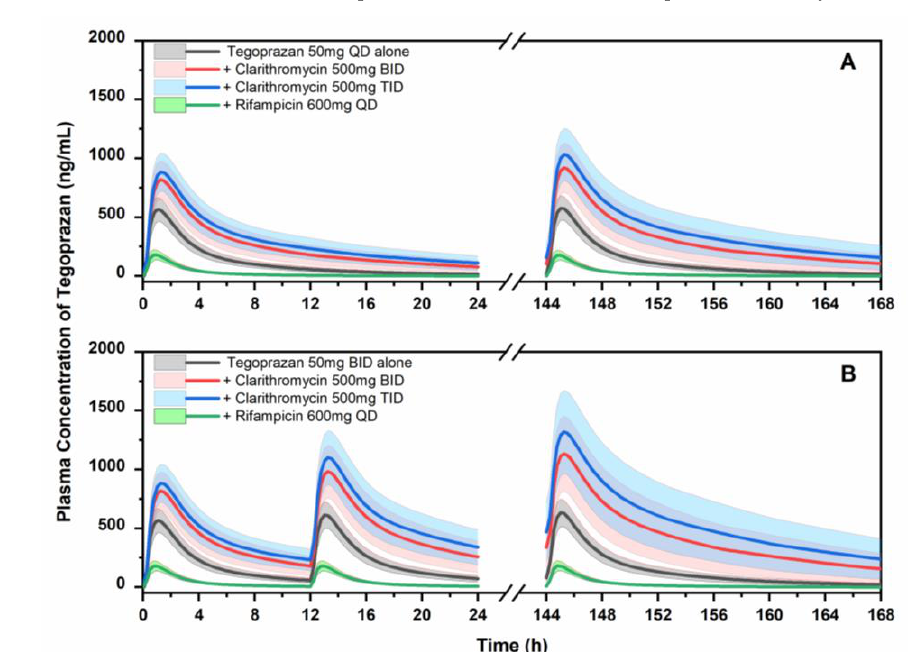
Figure 5. The PK profiles of tegoprazan following the administration of tegoprazan alone or with CYP3A4 perpetrators in a variety of scenarios. ( A ) Tegoprazan, 50 mg, once daily; ( B ) Tegoprazan, 50 mg, twice daily. Dose of clarithromycin: 500 mg, twice or three times daily. Dose of rifampicin: 600 mg, once daily.